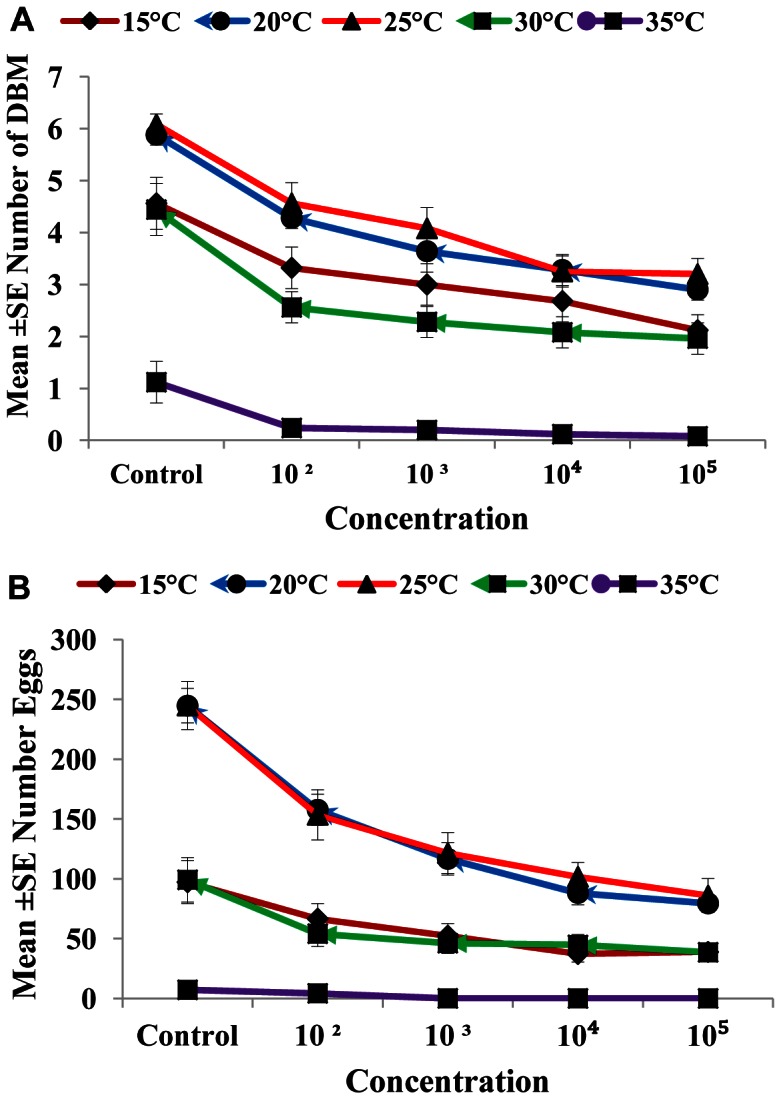
Influence of Nosema concentration and different temperatures on adult emergence and egg production.Data represent the mean ± SE of number of adults emerged (a), number of eggs produced by DBM adults (b) developed from Nosema infected DBM larvae at 15°, 20°, 25°, 30° and 35°C. Vertical bars = S.E.